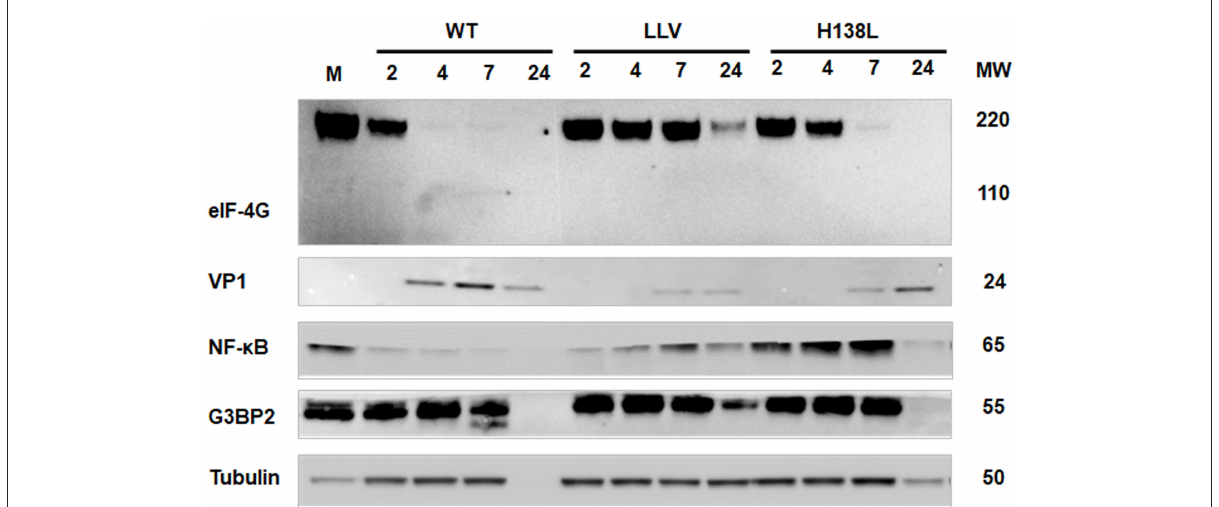
FIGURE3 Processing of cellular proteins. LF-BK cells were infected with FMDV A12-WT, A12-LLV (leaderless) or FMDV A12-L H138L at MOI = 10. Protein cytoplasmic extracts were collected at 2, 4, 7, and 24h post infection, followed by SDS PAGE and Western Blot analyses using anti-eIF4G (p220), anti-FMDV VP1, anti-NF- κ B (p65/RelA), anti G3BP2, and anti-tubulin- α antibodies. M stands for mock infected